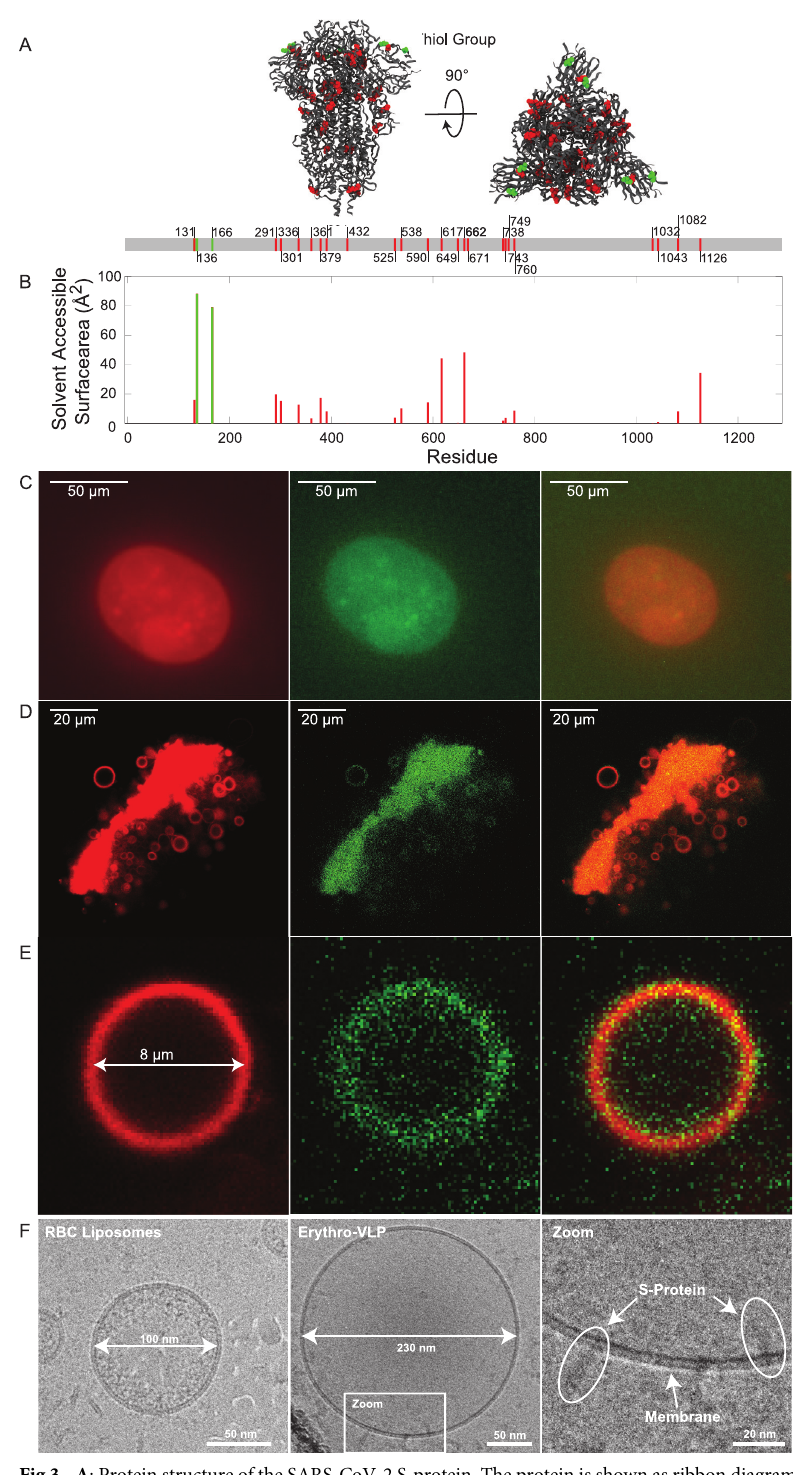
Fig 3. A : Protein structure of the SARS-CoV-2 S-protein. The protein is shown as ribbon diagram and cysteine is shown as sphere. The red and green color indicates solvent accessible and non-accessible cysteine residues. The Solvent Accessible Surface Area (SASA) was determined by the Getarea software and is graphed in B . C : Epifluorescent microscopy images of giant Erythro-VLPs grown on agarose gel. The membrane was stained in red using TR-DHPE; the SARS-CoV-2 S-protein was stained in green using Alexa Fluor 488 maleimide. D : CLSM images of a cluster of